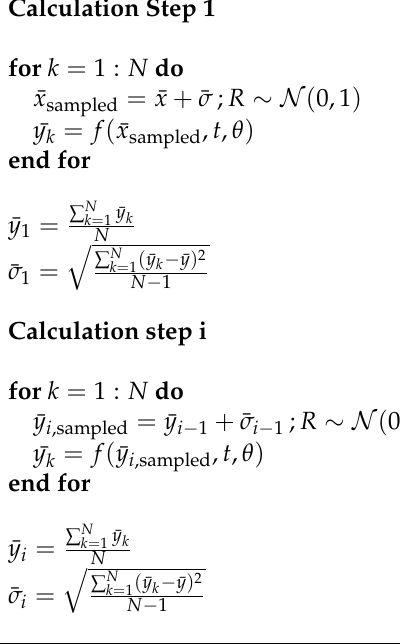
Algorithm 1 Monte Carlo sampling for error propagation